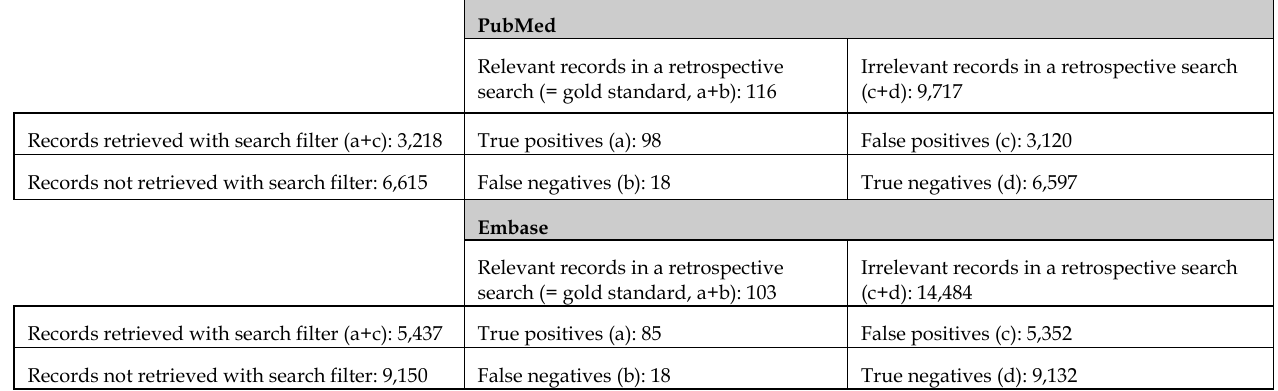
Table 3 Overview of the original intervention study search filter’s performance in PubMed and Embase in the derivation reference gold standard